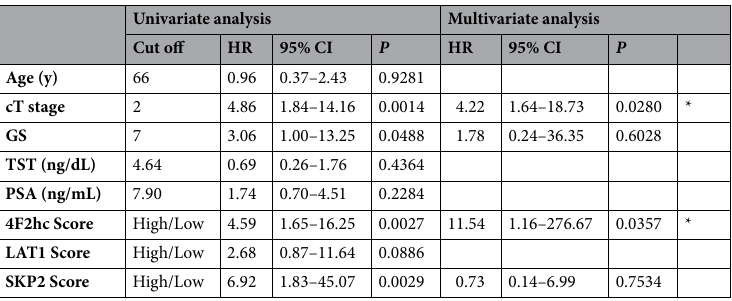
Table 2. Predictors of progression-free survival. HR = Cox proportional hazard ratio, 95% CI = 95% confidence interval, cT stage = clinical tumour stage, GS = Gleason score, TST = testosterone, PSA = prostate- specific antigen. *Statistical significance ( p < 0.05).